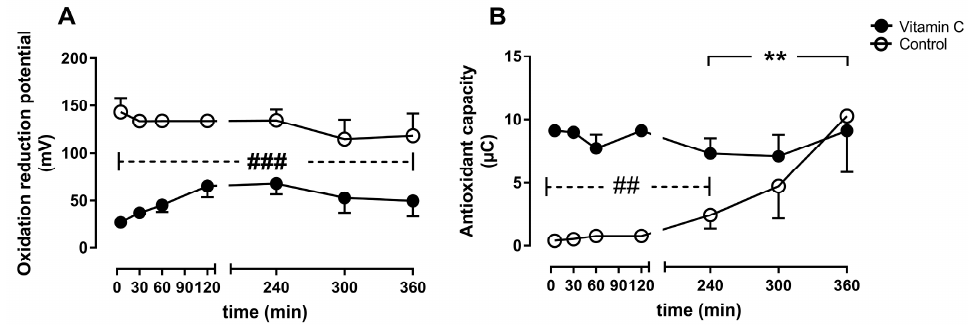
Figure 7. Oxidative stress was assessed as oxidation reduction potential ( A ), and antioxidant capacity ( B ). ** p < 0.01 e ff ect of time for the control group; ## p < 0.01 vs. control, ### p < 0.001 vs. control.